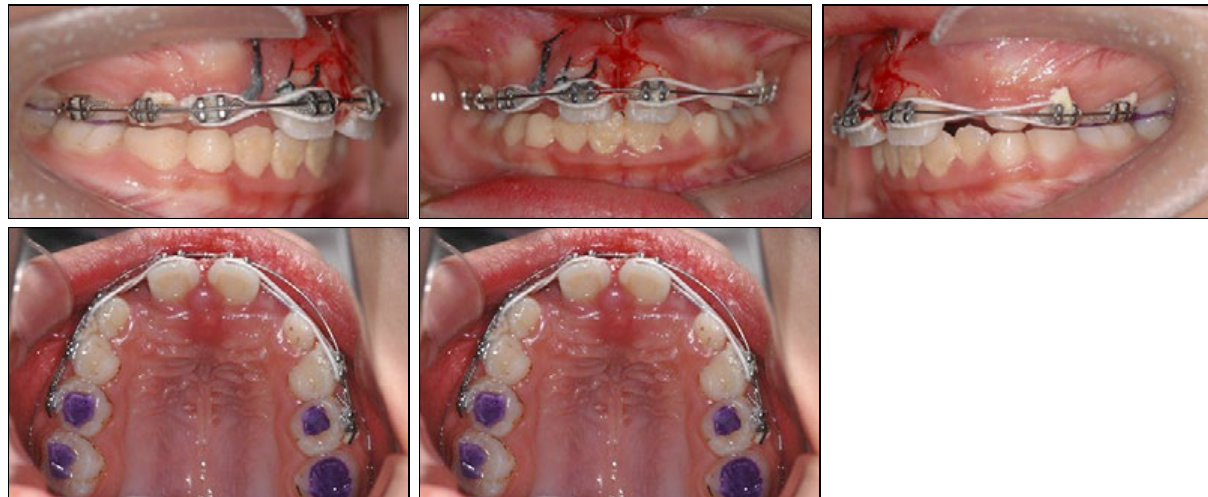
Figure 4. Intraoral photographs during phase one treatment. Placement of a TAD and adhesive bite-blocks. TAD, temporary anchorage